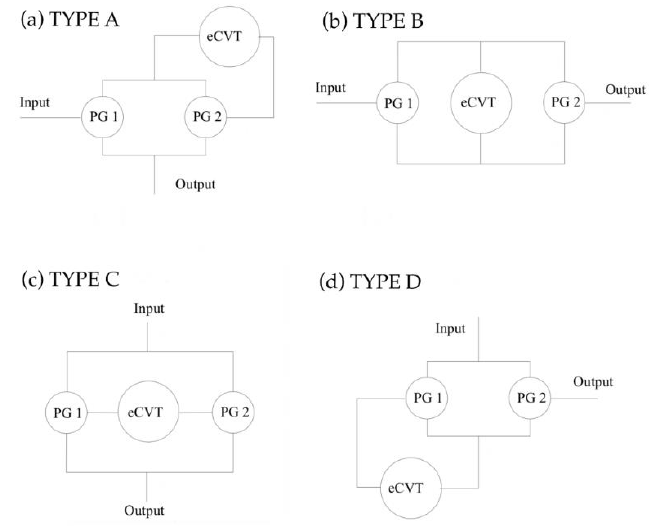
Figure 1. Compound eCVT based on the four-port-mechanical power-split device: ( a ) type A arrangement; ( b ) type B arrangement; ( c ) type C arrangement; ( d ) type D arrangement.